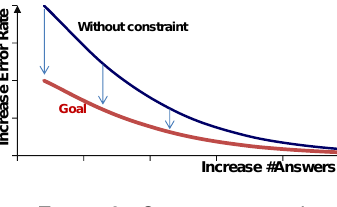
Figure 3. Optimization goal Figure 3 depicts this situation: higher number of answers correspond to lower error rates. We would like to lower this error-rate curve as much as